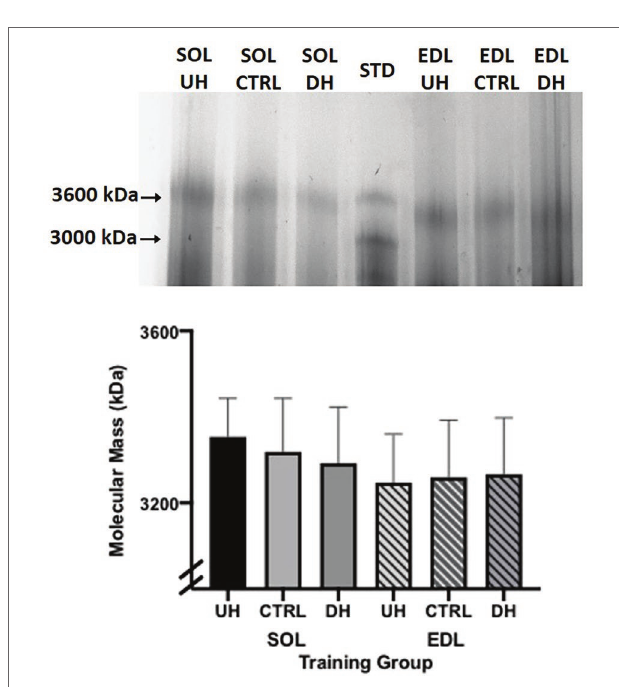
FIGURE 4 | Top panel : example sodium dodecyl sulfate vertical agarose gel electrophoresis (SDS-VAGE) gel showing titin bands for SOL and EDL UH, CTRL and DH groups, and standard (STD) lane containing rat cardiac and gastrocnemius. Bottom panel : mean (+SEM) titin molecular mass (kDa) following 4 weeks of treadmill training and sedentary control. Solid bars (SOL) and striped lines [EDL; n = 4; p = 0.31 (SOL) and p = 0.53